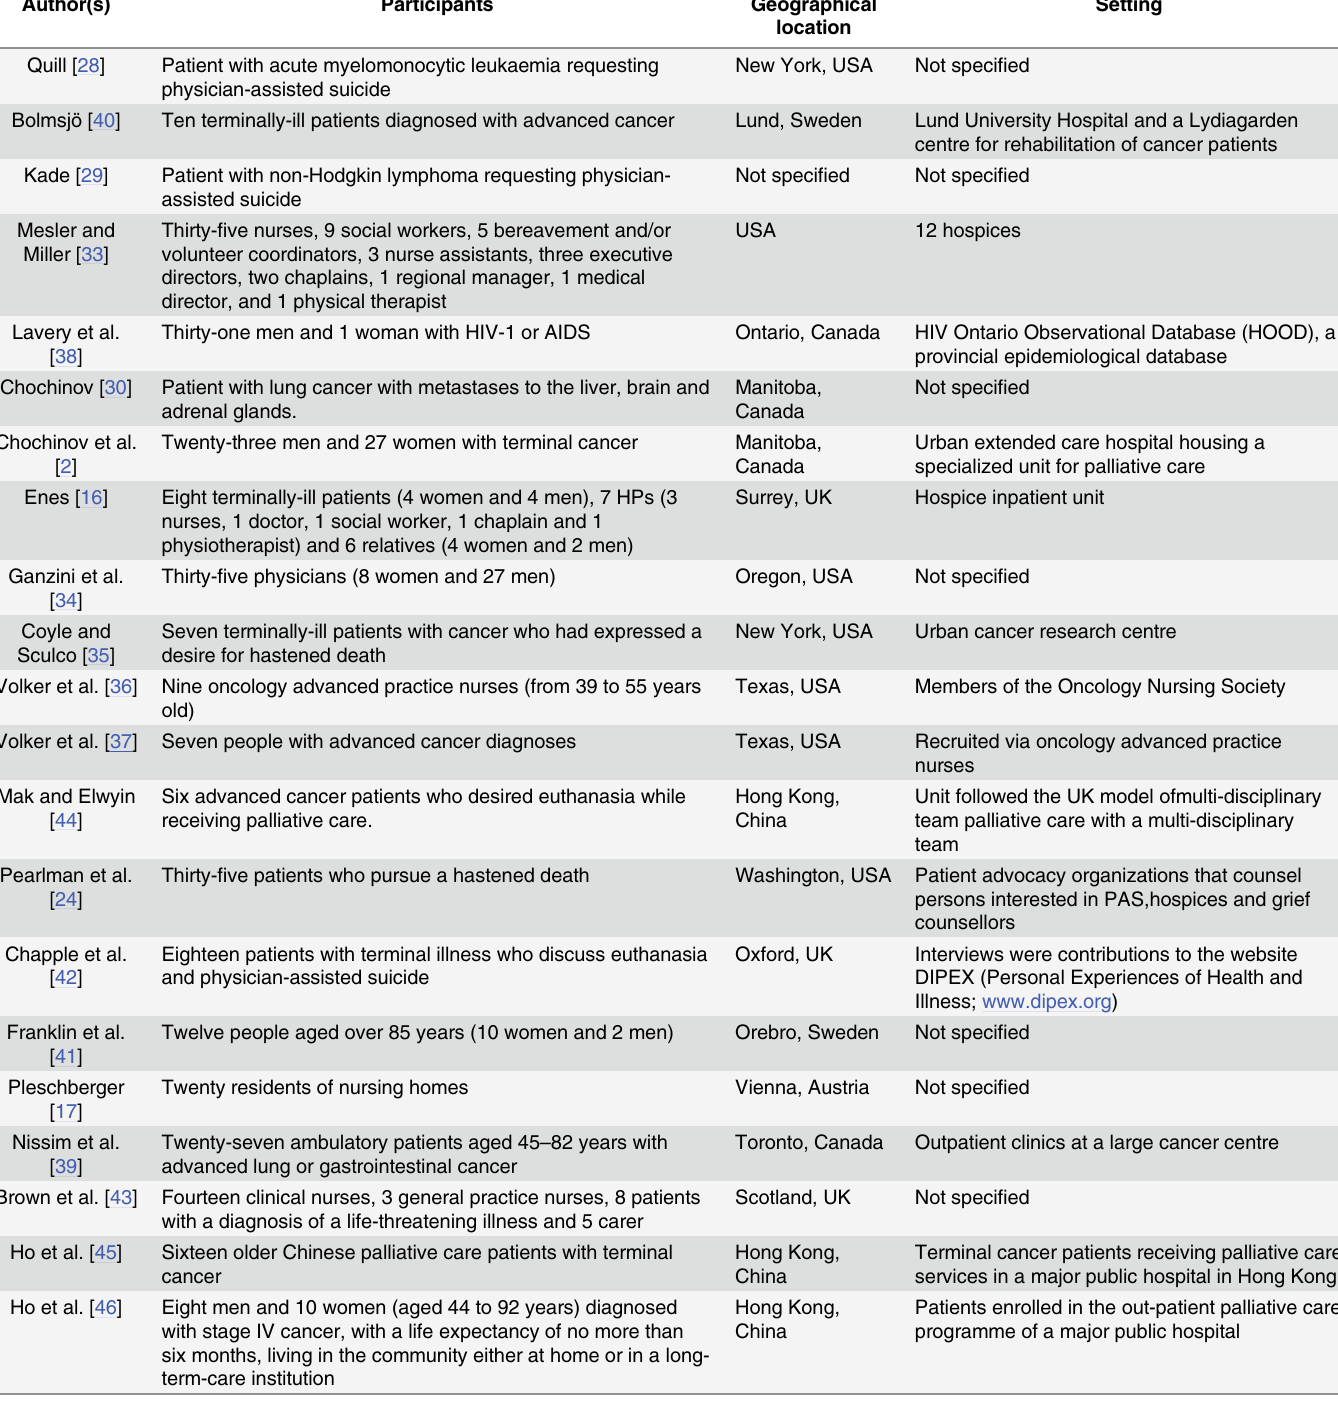
Table 2. Description of studies included in the